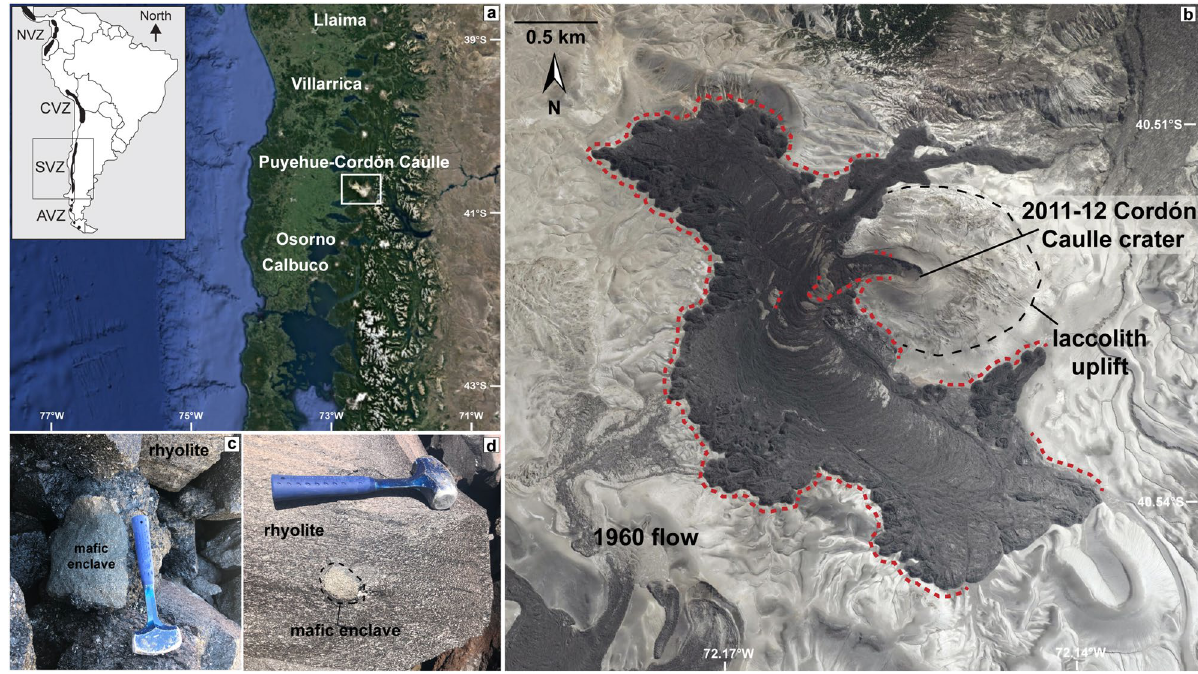
Figure 1. ( a ) Overview map of the SVZ of the Andes with inset of South America 15 . Overview map generated from Google Earth (Jan 2022; Image Landsat/Copernicus). White box identifies Puyehue-Cordón Caulle field area. ( b ) 2011–12 Cordón Caulle rhyolite lava flow. Image generated from Google Earth (Jan 2022; Image @ 2022 CNES/Airbus). Red dash: location of mafic enclave sampling for this study. Black dash: uplift area from laccolith 23 . ( c , d ) Field images of mafic enclaves hosted in rhyolite lava. Hammer for